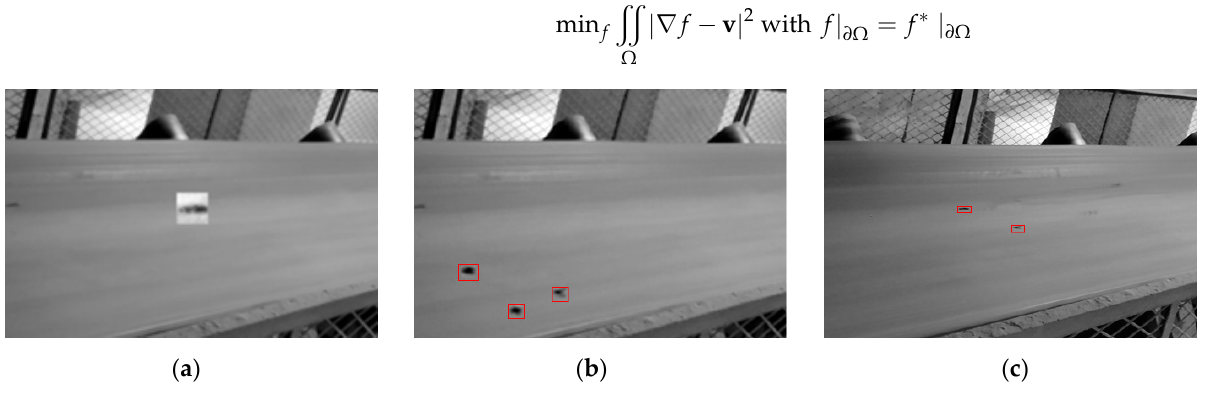
Figure 4. Data enhancement method of joint GAN and Copy-Pasting strategy. ( a ) Paste directly. ( b ) Poisson fusion. ( c ) Poisson fusion + random scale zooming. ( b ) Poisson fusion. ( c ) Poisson fusion + random scale